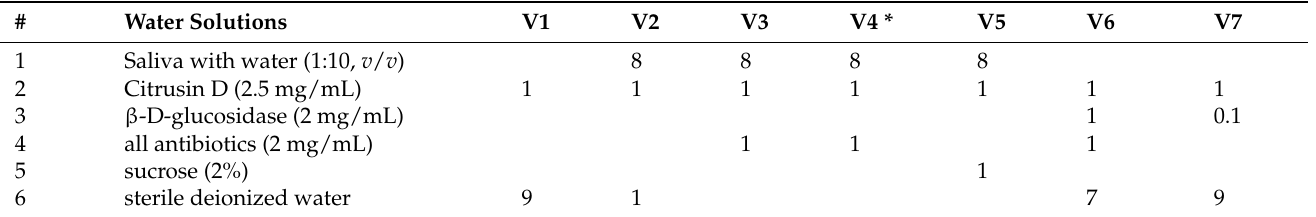
Citrusin D after synthesis using HR-MS (Figure S1). Table 1. Dosage (mL) of individual solution to sterile vials (V1–V8). V5 *-VIAL number 5 contains: saliva + antibiotics and after 24 of incubation 37 ◦ C and then glucoside